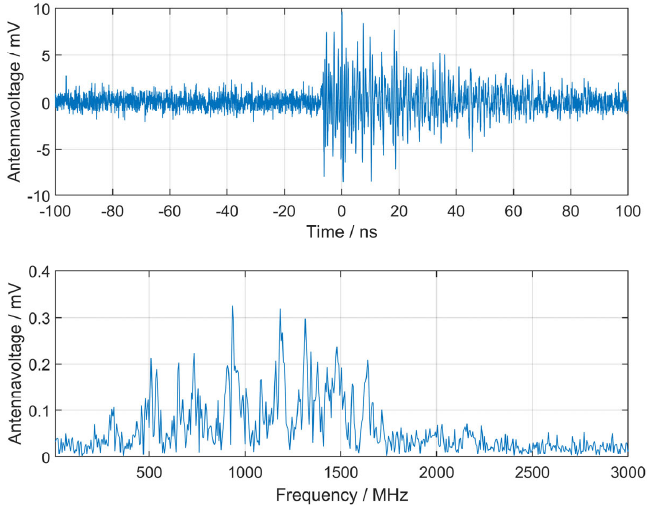
Figure 11. Time ‐ domain signal and frequency spectrum of the same signal obtained from the in ‐ Figure 11. Time-domain signal and frequency spectrum of the same signal obtained from the installed stalled sensor.